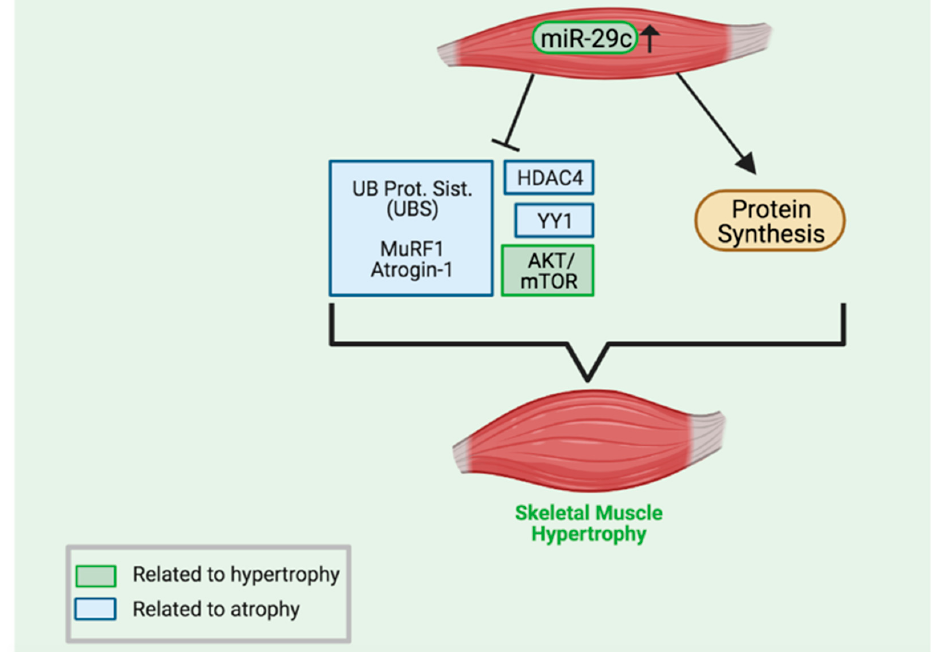
Figure 6. A summary of the pathways that are known to be impacted by high levels of miR-29c. MiR-29c-inhibited pathways are shown on the left (blue rectangles represent atrophy pathways and green rectangle relate to hypertrophic pathways). Please refer to [11,19] for more information. The present work shows that, despite the considerable increase in protein synthesis, components of the AKT/mTOR pathway are downregulated. The main results of miR-29c skeletal muscle overexpression are increased force and skeletal muscle development (for details see [11]).